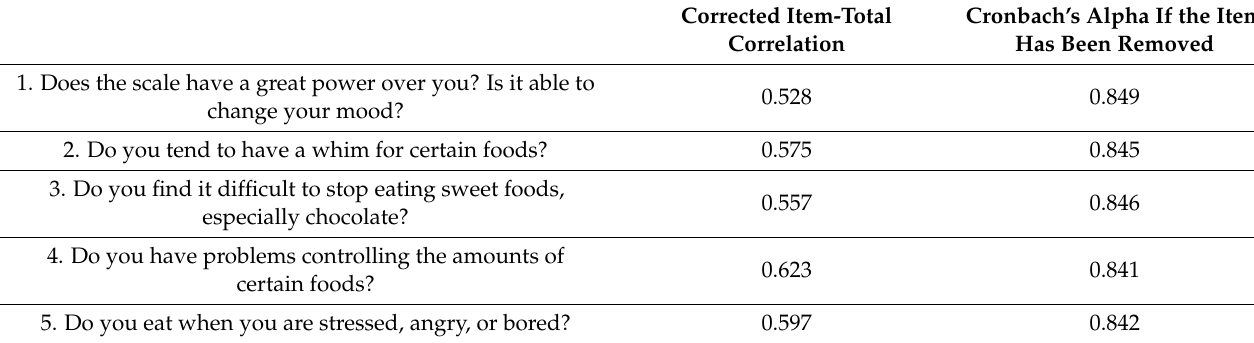
Table 6. Reliability results of the EEQ items ( p <